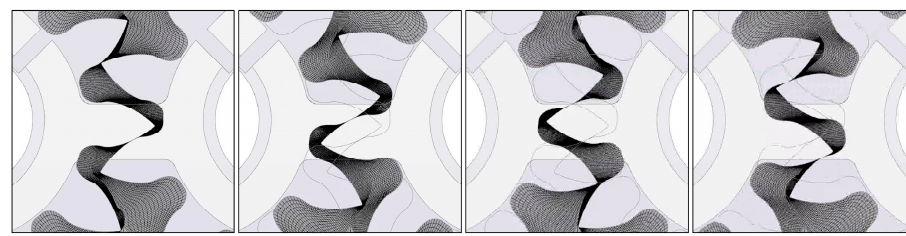
Figure 3. Subsequent instants of engagement process discretized by means of a dynamic mesh strategy.